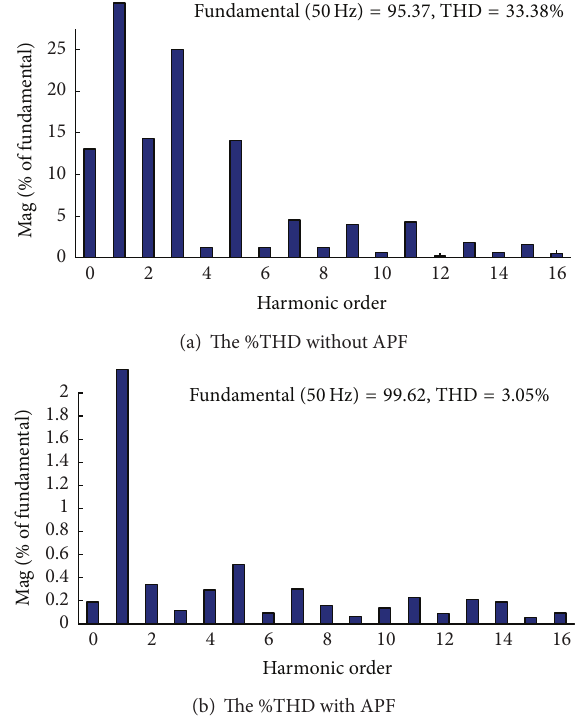
Figure 10: Harmonic spectrum analysis of phase 𝐴 before compen- sation and after compensation.